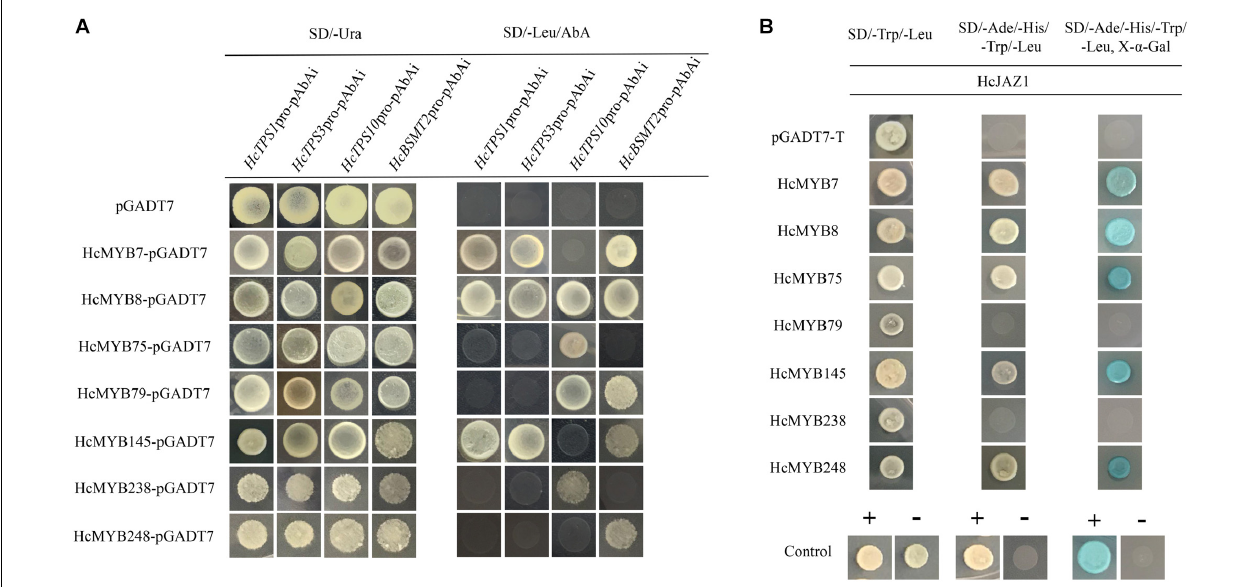
FIGURE 7 | Candidate HcMYB proteins binds to the promoters of bottom structural genes. (A) The interaction was determined on SD medium lacking leucine (Leu) in the presence of aureobasidin A (-Leu + AbA). AD was used as a control. (B) HcMYB7/8/75/79/145/238/248 interacts with HcJAZ1 protein by yeast two-hybrid assay. The vectors were transformed into yeast strain Y2HGold followed by the screening of transformants via SD/-Trp/-His/-Ade + X- α -gal media. Yeast cells transformed with pGBKT7–53 + pGADT7-T, pGBKT7-Lamin + pGADT7-T, or pGADT7-T- pGBKT7-HcJAZ1 were included as negative or positive